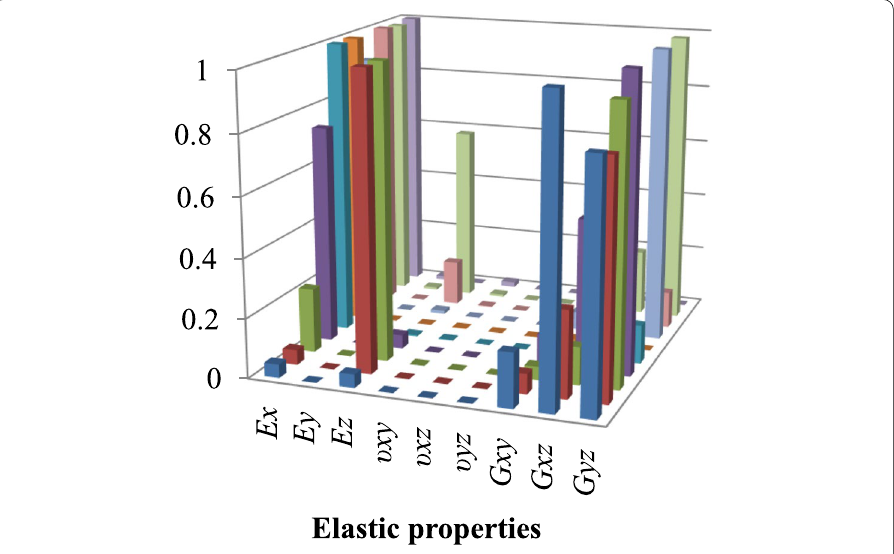
Fig. 16 Sensitivity analysis for